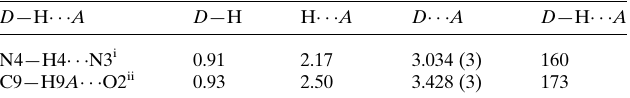
Table 1 Hydrogen-bond geometry (A˚ , (cid:5) ).